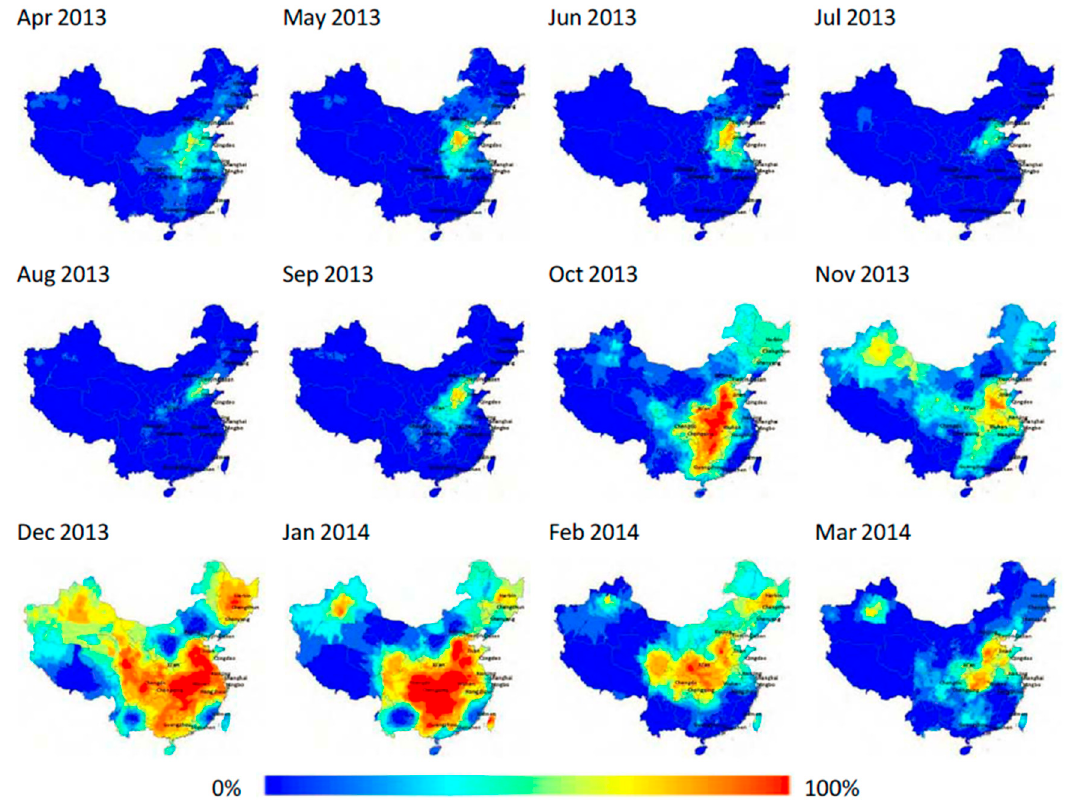
Figure 4. Spatiotemporal variation of PM 2.5 exposure duration. The color ramp represents the percentage of days with PM 2.5 concentration exceeding China’s daily standard for each month between 8 April 2013 and 7 April 2014. No ground observations are used for Taiwan, Hong Kong, and Macau. The spatial resolution is subdistrict.